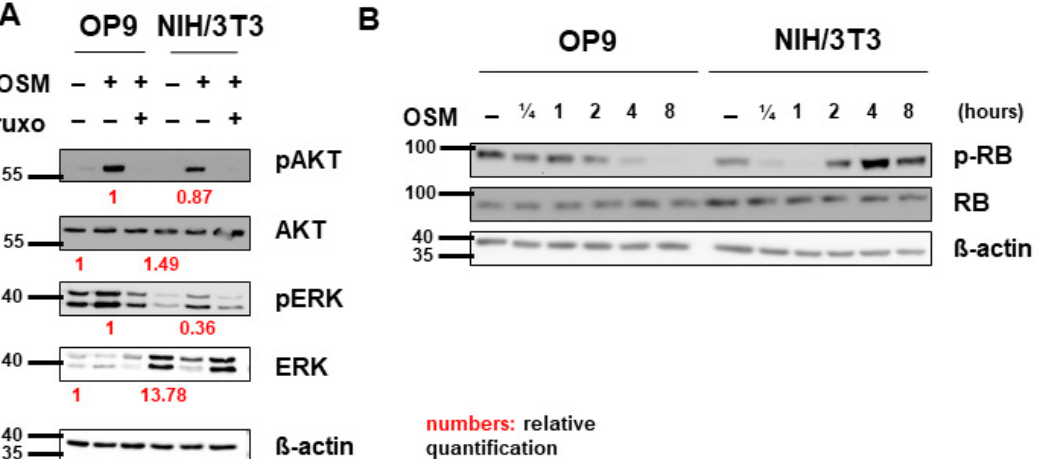
Figure 5. Pathway activation patterns were consistent with the OSM effect on proliferation. ( A ) OP9 and NIH/3T3 cells were used to examine the expression and activation of the MAPK-AKT and PI3K-ERK pathways at 10 ng/mL mOSM +/ − 1 µ M ruxolitinib. Cells were serum-starved overnight. Ruxolitinib was added after 2 h and mOSM 15 min before harvesting the cells. Protein molecular weight is labeled in kDa. Relative protein quantities are indicated in red. ( B ) OP9 and NIH/3T3 cells were used to examine the expression and phosphorylation of retinoblastoma protein (RB) by mOSM for different time periods. Protein molecular weight is labeled in kDa.